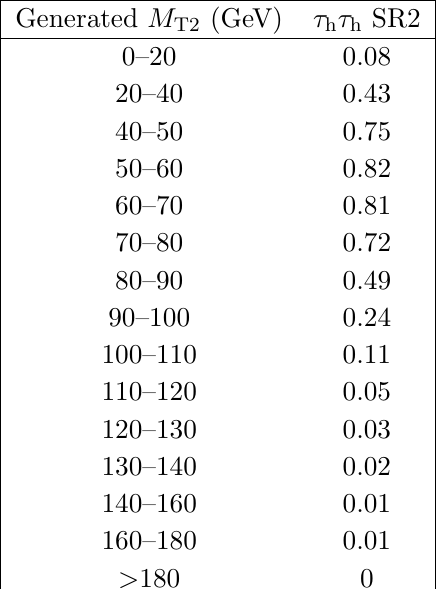
requirement in ‘(cid:28) h channels versus generated M (cid:28) h T